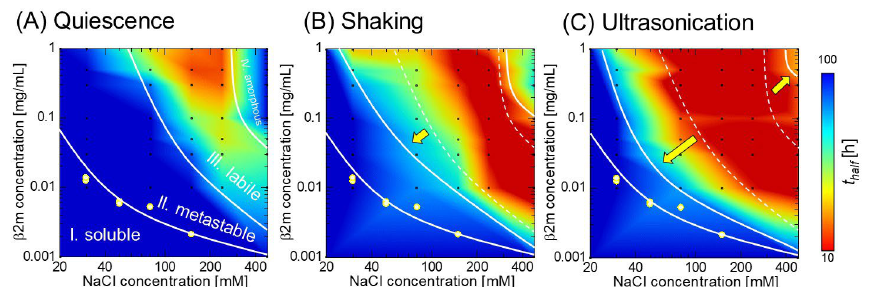
Figure 6. t half heat maps of aggregation reactions. ( A ) Under quiescence, ( B ) under shaking, and ( C ) under ultrasonication. The yellow dots denote the solubility of acidic β2m monomer at each salt concentration, determined by ultracentrifugation and the ELISA assay . The dotted lines in panels ( B ) and ( C ) indicate the phase boundaries under quiescence, which are varied under agitation as indicated by yellow arrows. The figure is reproduced from Nakajima et al. [104] with permission. Copyright 2021 American Chemical Society.